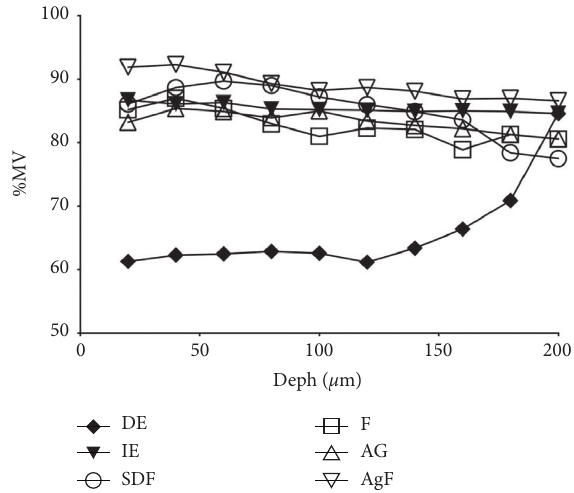
Figure 4: The percentage representation of mineral volume (%MV) in depths according to experimental